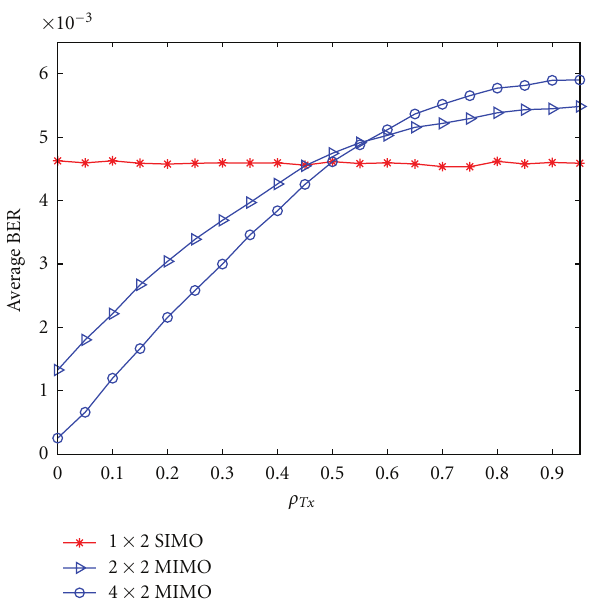
Figure 6: BER performance versus transmit correlation coe ffi cient, for CM2 channels.